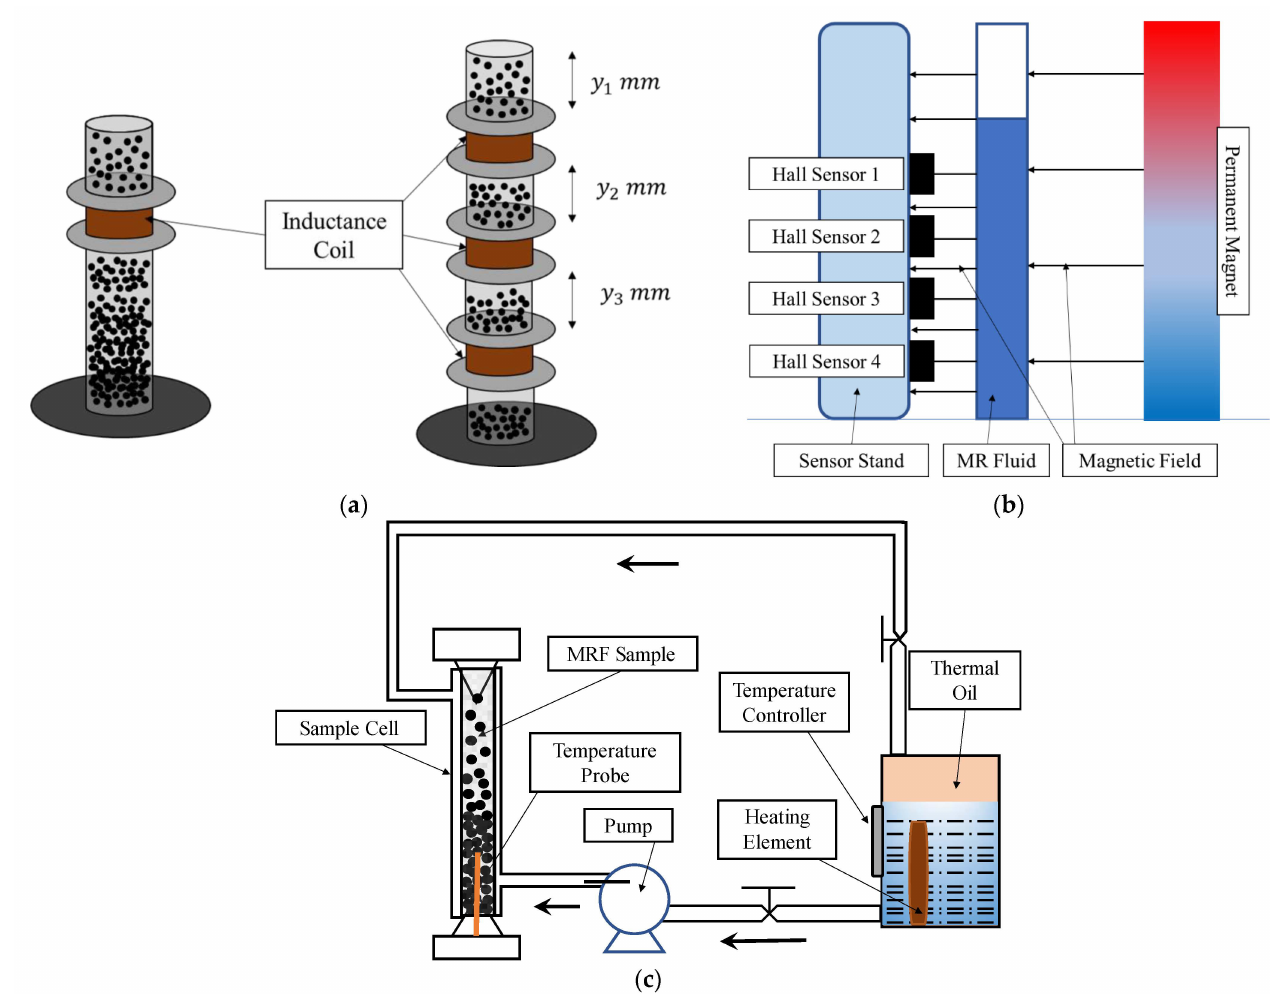
Figure 5. Measurement Methods for Sedimentation Rate of MRFs; ( a ) use of inductance coil, ( b ) use of hall sensor, and ( c ) use of thermal